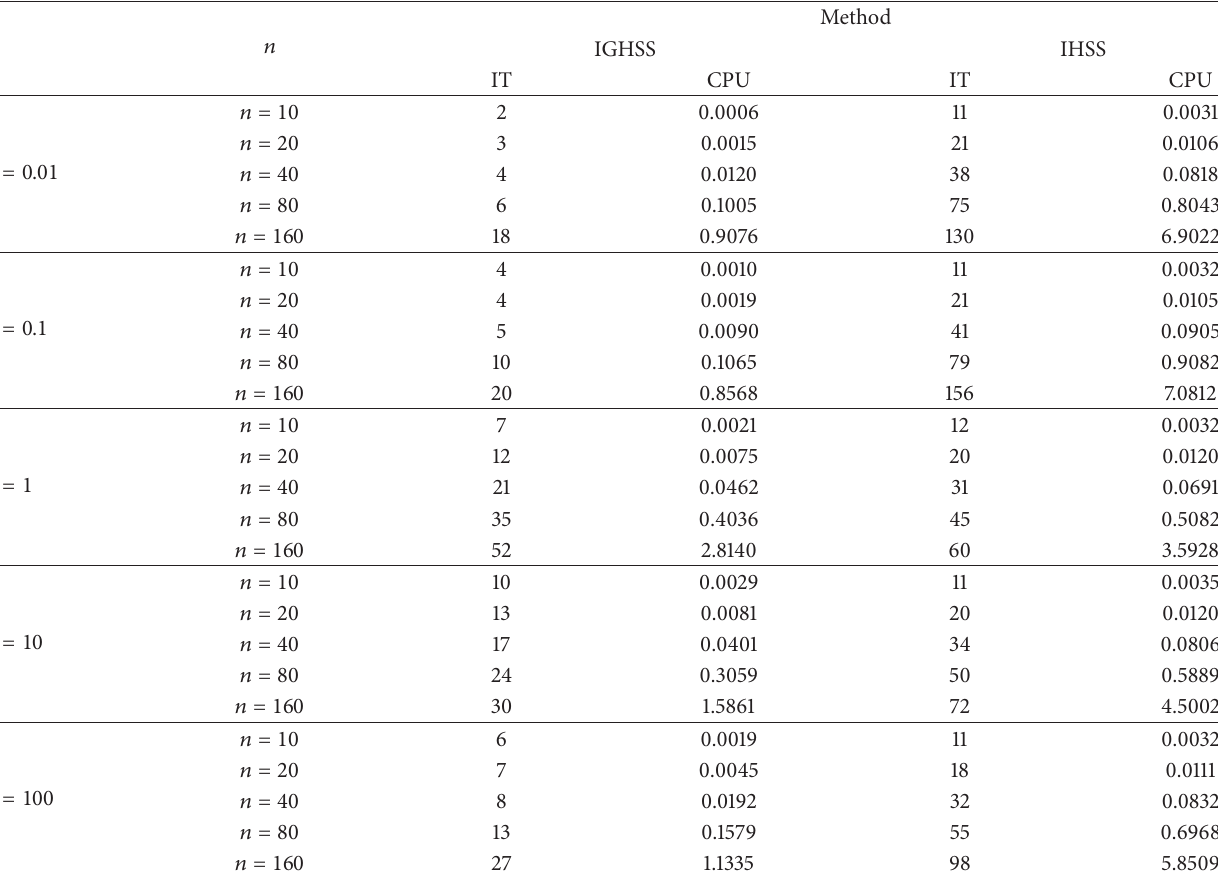
Table 3: Numerical results for IGHSS and